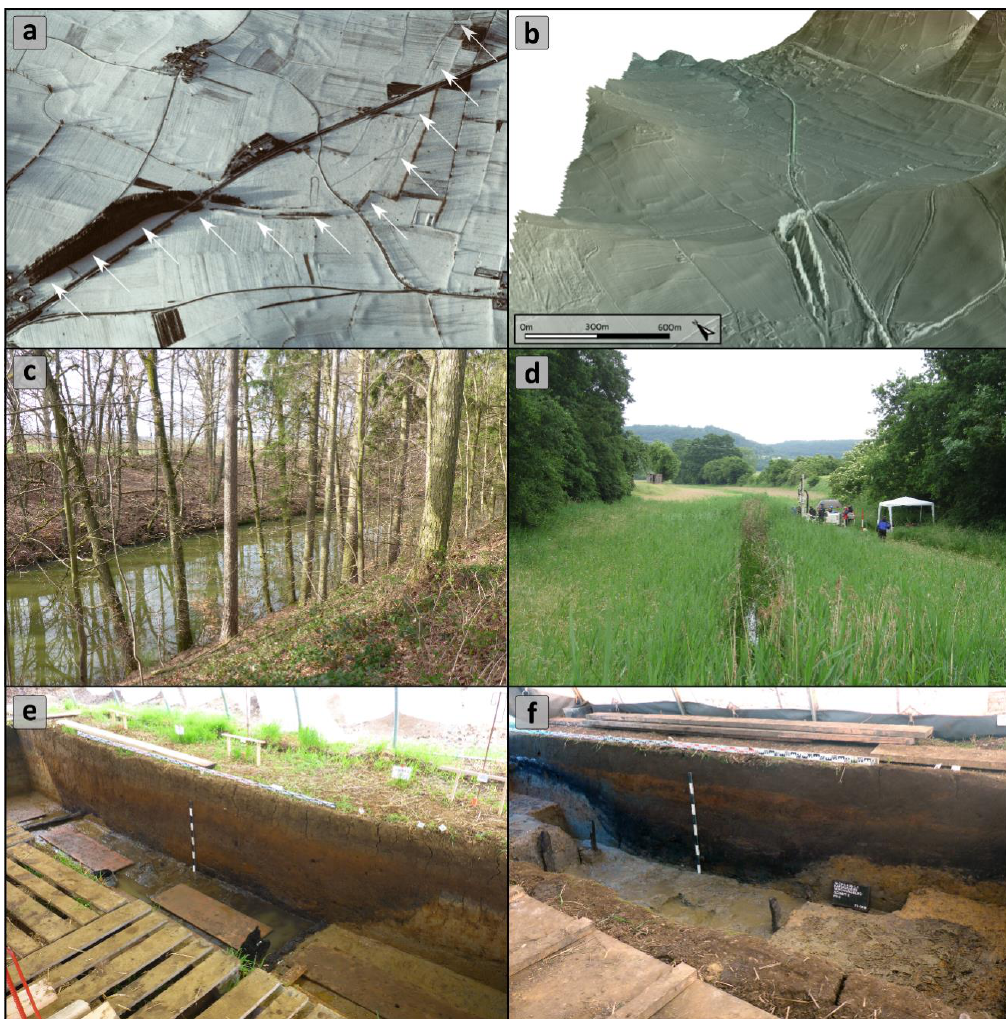
Figure 3: Impressions of the Fossa Carolina. a ) Aerial image of the canal with shadow marks highlighting terrain differences, white arrows show the canal course [43], b ) 3D view of the present Digital Terrain Model (DTM) derived from LiDAR-data, which shows the prominent dams and extent of the construction, c ) Central Section with afforested dams (Photo: Lukas Werther), d ) West-East Section with drainage ditch, lateral dams and ongoing direct push sensing (Photo: Johannes Völlmer), e ) Canal profile in the North-Eastern Section of the Fossa Carolina (2016 – S1) during the excavation. The trench which has been excavated in 793 AD is clearly visible, the trench bottom is not yet excavated. Oak piles mark the Eastern edge of the fairway (Photo: Lukas Werther; see also Figure 8b), f ) Canal profile at the Northern end of the Fossa Carolina (2016 – S2) with least depth, width and excavated volume. The trench which has been excavated in 793 AD and later filled is clearly visible. North of the profile, oak stakes mark the edges of the fairway (Photo: Lukas Werther; see also Figure 8c).